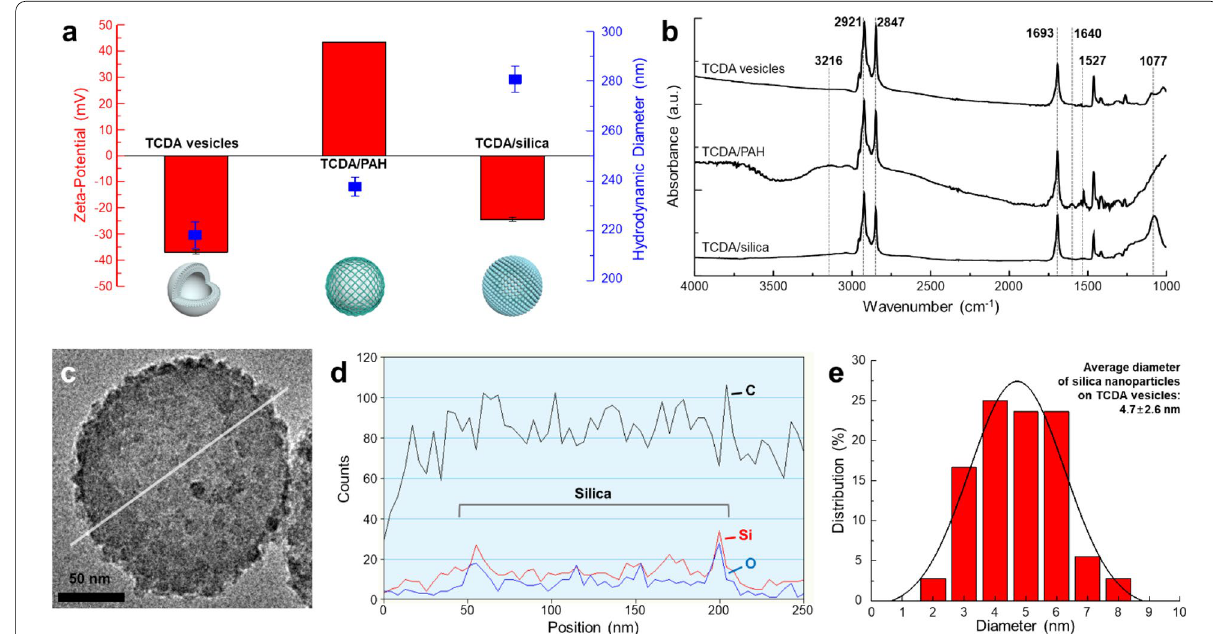
Fig. 1 a Surface charge (left axis) and hydrodynamic diameter (HDD, right axis), and b Fourier transform infrared spectroscopy (FTIR) spectra of 10,12-Tricosadiynoic acid (TCDA) vesicles with different surface layers. c Transmission electron microscopy (TEM) image of monomeric TCDA/silica and d Energy dispersive spectroscopy (EDS) spectra of section shown by the white line in c . e Size distribution of silica nanoparticles on the TCDA